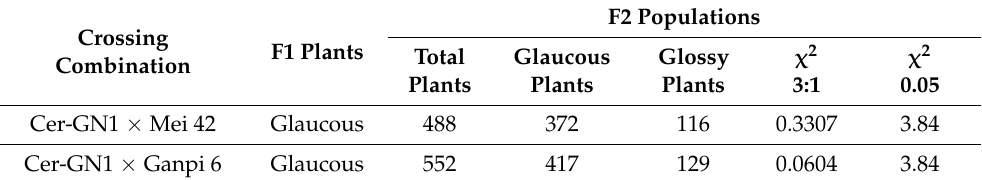
Table 1. Characteristics of the waxy spike phenotype of F1 and F2 genetic populations. F2 Populations Crossing F1 Plants Combination Plants